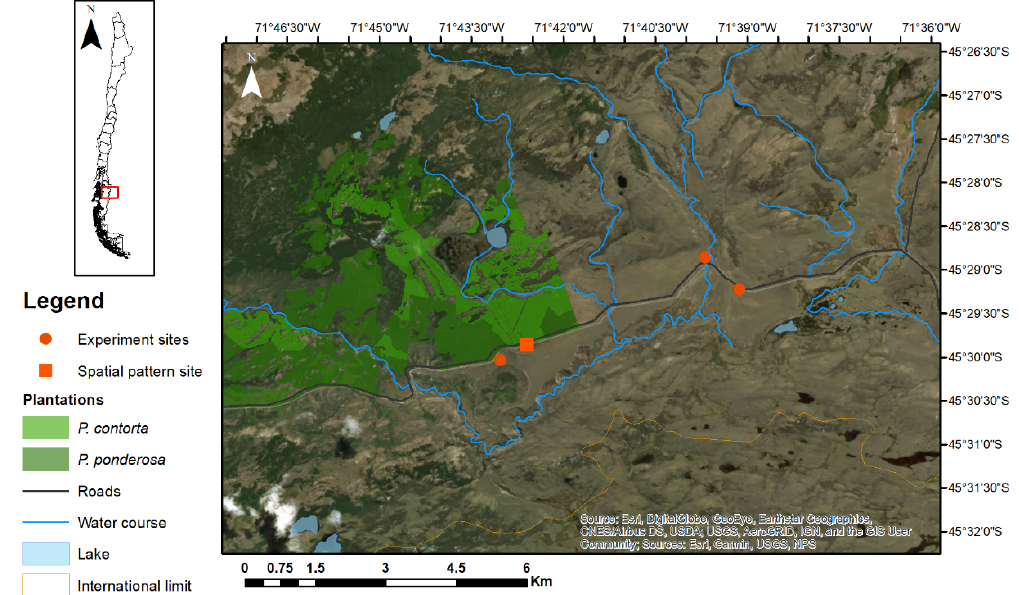
Figure 1. Study area showing the four study sites in the Patagonia steppe of Chile.